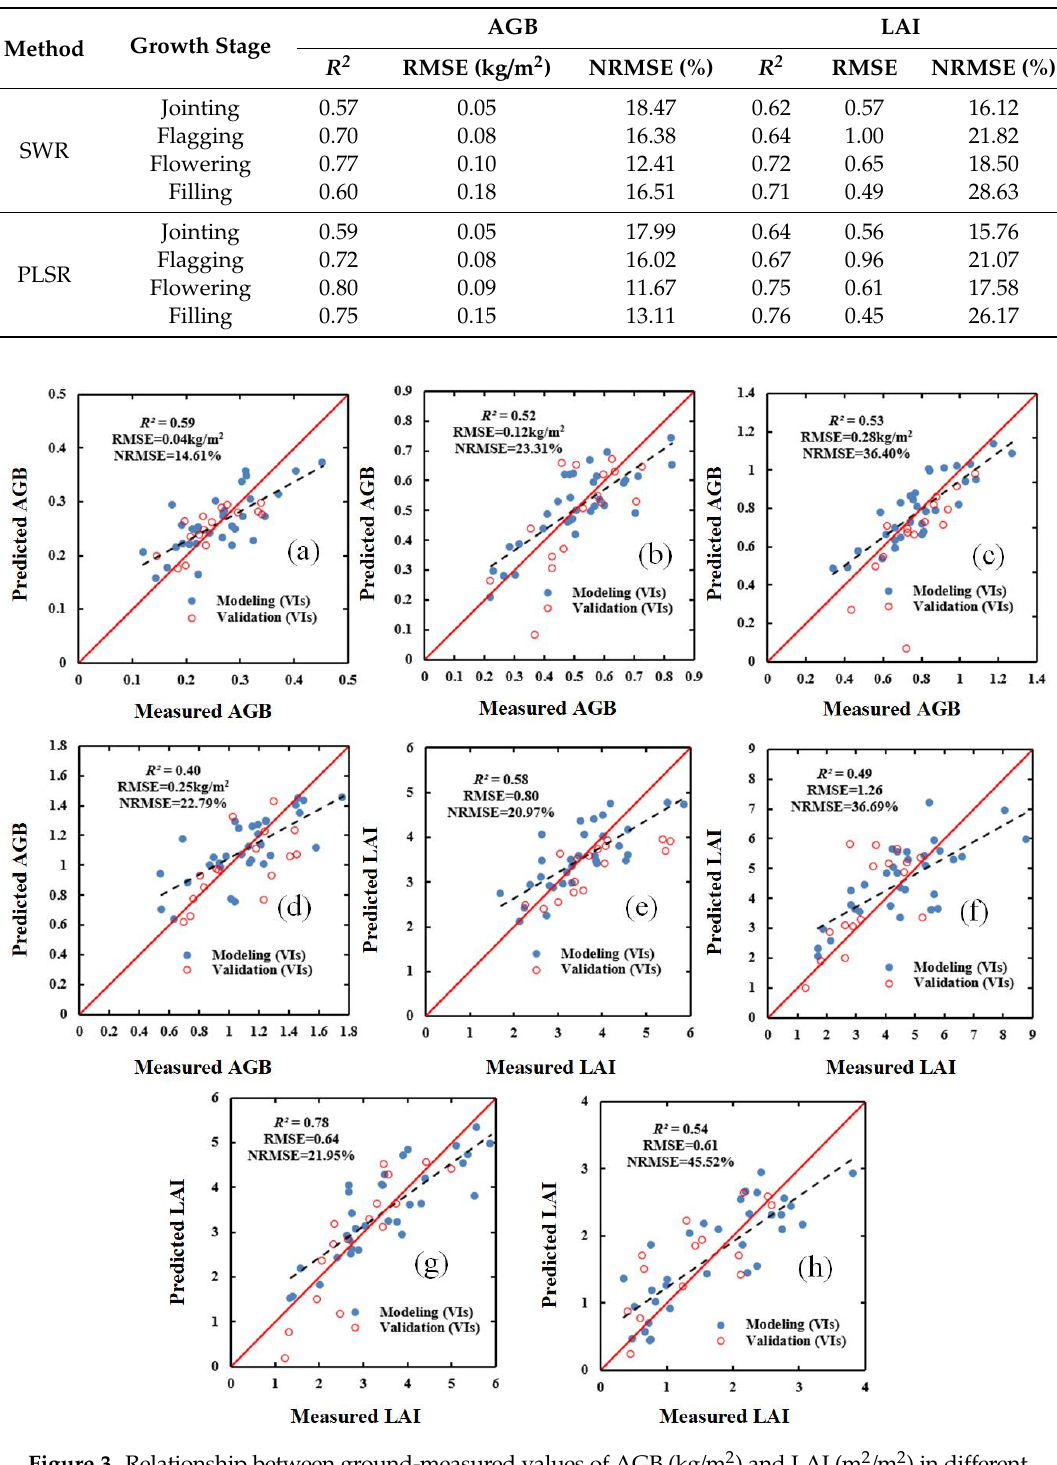
Table 8. Performancemetricsfortheestimationofwinter-wheatAGBandLAIobtainedusingacombination of vegetation indices and red-edge parameters (modeling dataset) for the four growth stages.